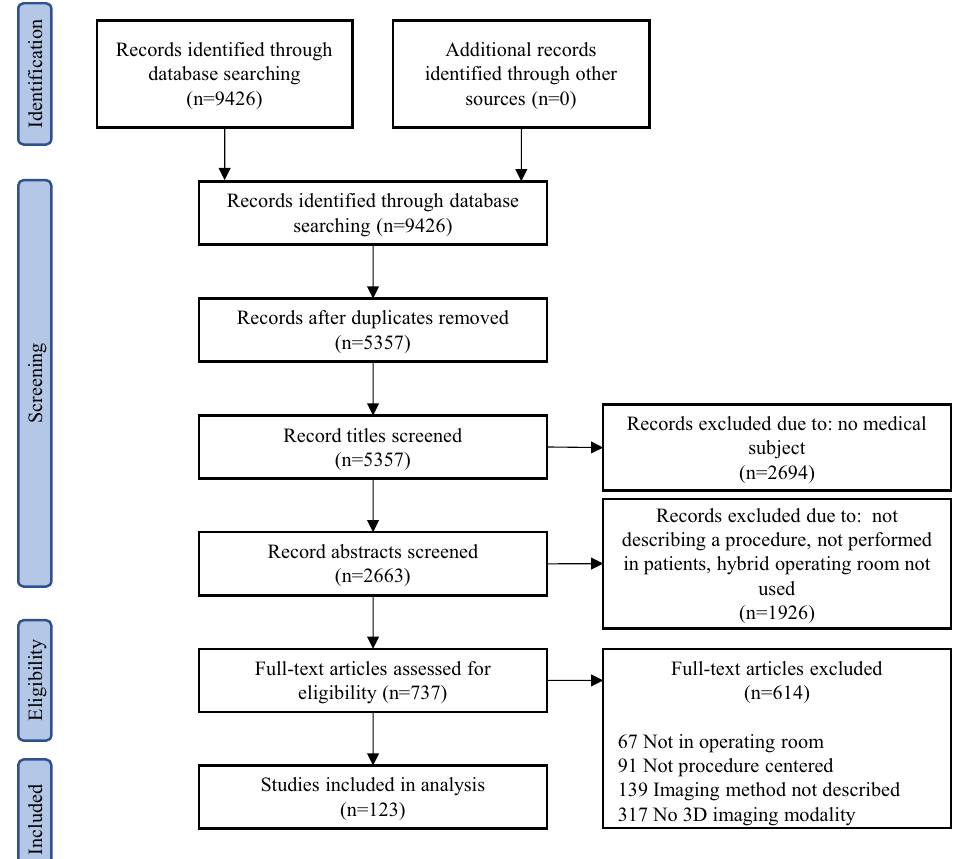
Fig 1. PRISMA flowchart of the study selection